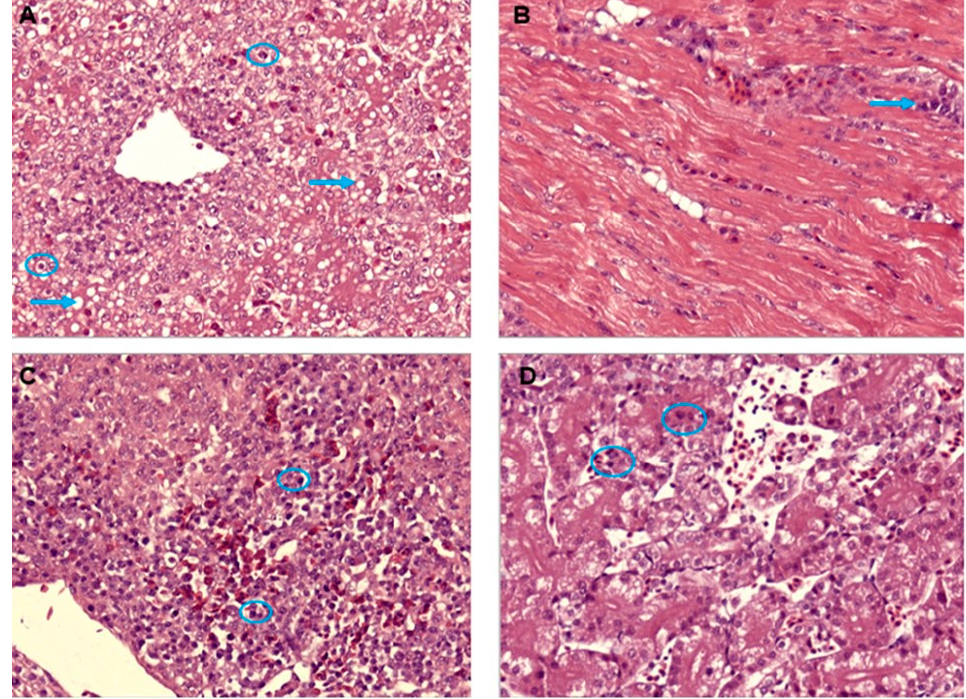
Figure 4. Histologic lesions of natural Avian Adenovirus infection. H&E staining, ×400. ( A ) The liver, hydropic and vacuolar degeneration in hepatocytes (blue arrows) with basophilic intranuclear inclusion body in liver cells (blue circles). ( B ) The heart—monocytes and macrophages infiltration in interstitial areas (blue arrow). ( C ) The spleen—reticuloendothelial cells hyperplasia with intranuclear inclusions bodies (blue circles). ( D ) Kidney—hyperemia and degeneration of the epithelium in renal tubules with intranuclear inclusions bodies (blue circles).